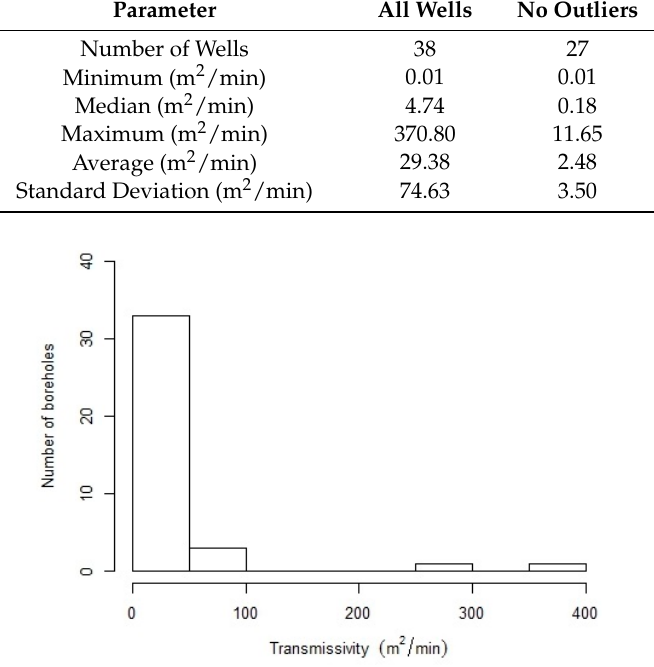
Figure 3. Pumping test-derived T values from 38 boreholes across Kilombero Valley, with the data appearing to be skewed towards lower T values.